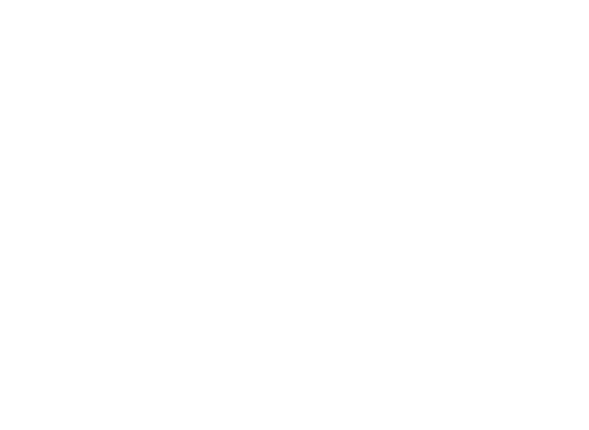
Fig. 1 : Showing AP and lateral radiograph of right lower end of femur.